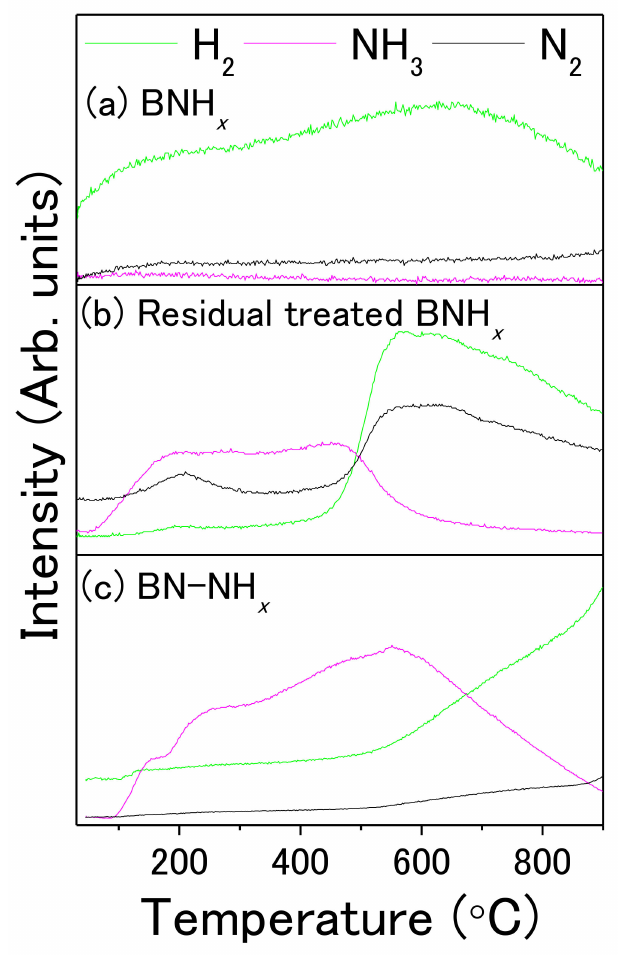
Figure 3. TG-RGA profiles of ( a ) BNH x , ( b ) residue of N 2 H 4 / NH 3 treated BNH x , and ( c ) BN-NH